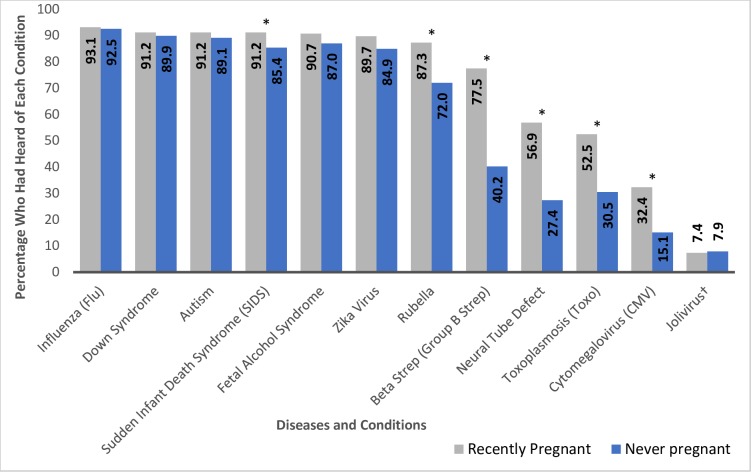
Awareness of diseases and conditions by pregnancy history.* Statistically significant differences between those recently-pregnant (grey bars) and those never-pregnant (blue bars) (chi-square test p-value < 0.05). + Jolivirus is a fictitious virus included to assess validity of survey responses.